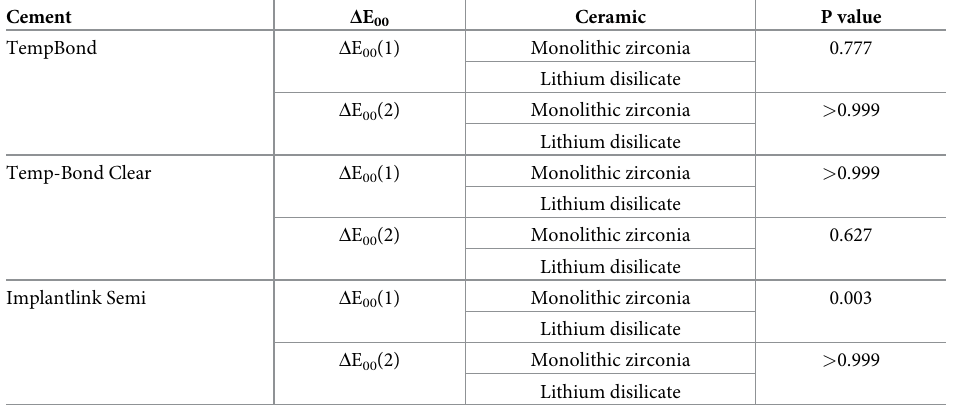
Table 3. Results of Mann-Whitney test for Δ E 00 differences between ceramic restorations in each temporary cement.